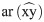
Mode of evaporation factor (MOEf).(a) Determination of MOEf using area measurements from MOE plot. Here, ar(xy^), stands for area of the sector x0y. As cd^ is a non-circular arc, it is segmented into small sectors at the data points between c and d. Circular arc assumption is applied to each sector and area of sector c0d is obtained as sum of all. See S1 Supporting Information for details about area calculation ar(SS) (b) MOEf for the substrates in Fig 3. (c) MOEf plot for droplets with different initial volumes.